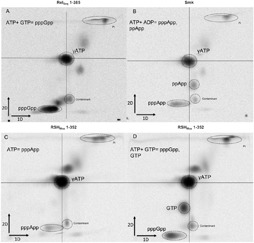
Two-dimensional TLC separation of (p)ppNpp’s synthetized by different enzymes. (A) RelSeq1-385 with 8 mM ATP + 8 mM GTP, (B) pyrophophokinase from S. morookaensis (Smk) with 8 mM ATP + 8 mM GDP, (C) RSHMex1-352 with 16 mM ATP, (D) RSHMex1-352 with 8 mM ATP + 8 mM GTP. The reaction mixtures contained 3.3 nM [P33] ɣ-ATP, 50 mM Tris–HCl (pH 8.9), and either 16 mM MgCl2 (RelSeq1-385 and Smk) or 8 mM CoCl2 (RSHMex1-352). 1D buffer: 3.3 M ammonium formate + 4.2% boric acid (pH 7), 2D buffer: 0.85 M KH2PO4 (pH 3.4).